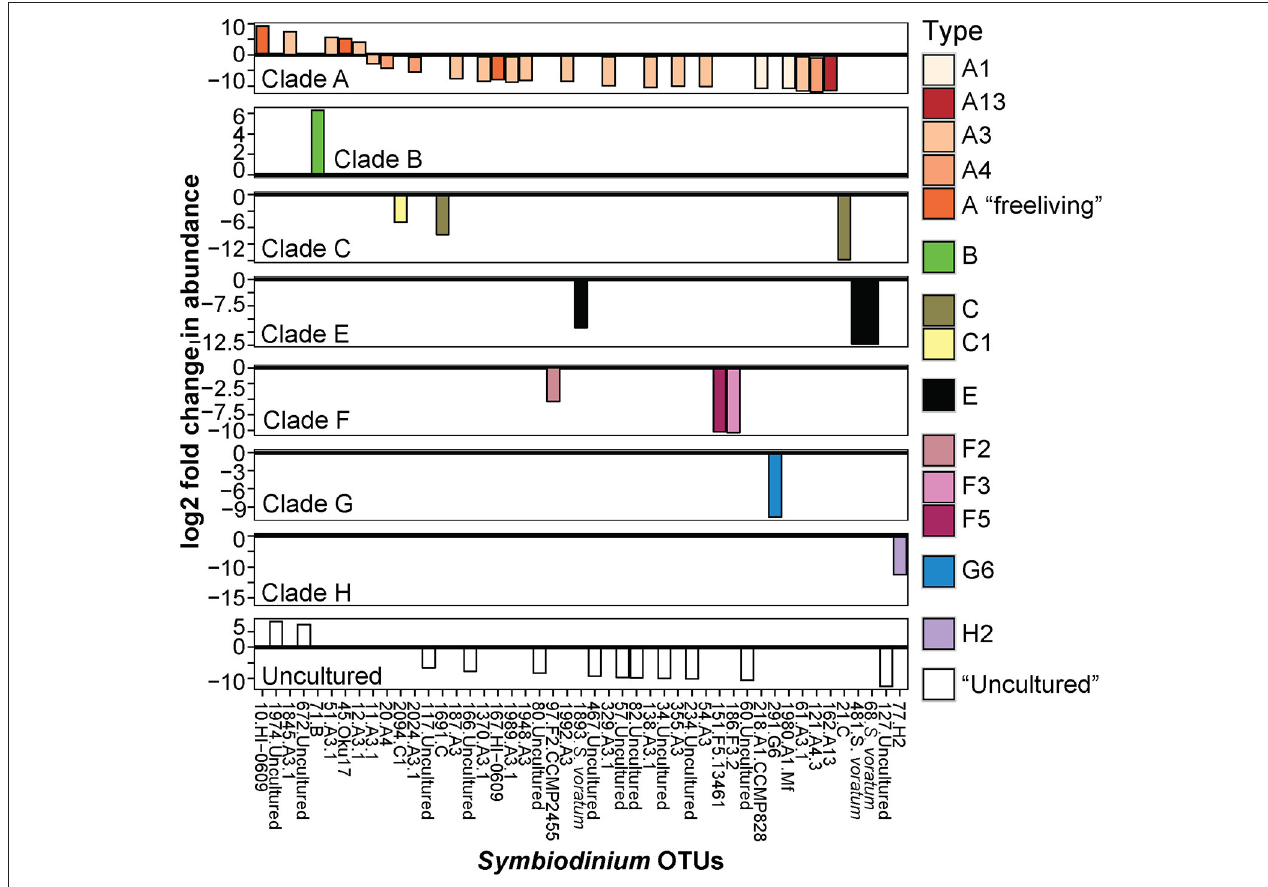
FIGURE 5 | Significant log2 fold changes in normalized abundances of Symbiodinium OTUs in central compared to northern sector sediments. Positive values above the y = 0 line (in bold and black) denote Symbiodinium OTUs found in significantly greater abundances in central sediments.